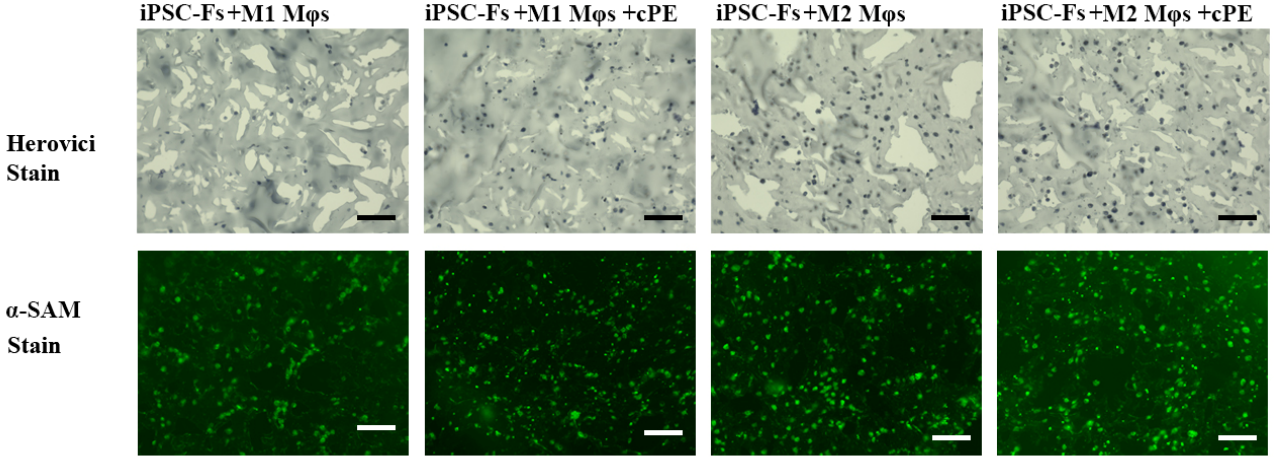
Figure 6. Herovici staining of collagen and immunofluorescent staining of α -SMA (scale bar, 100 µm).